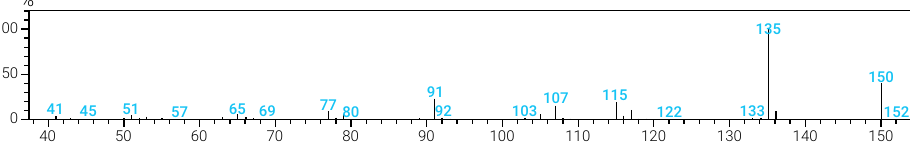
Figure 3. Thymol mass spectrum in L. thymoides chromatogram.